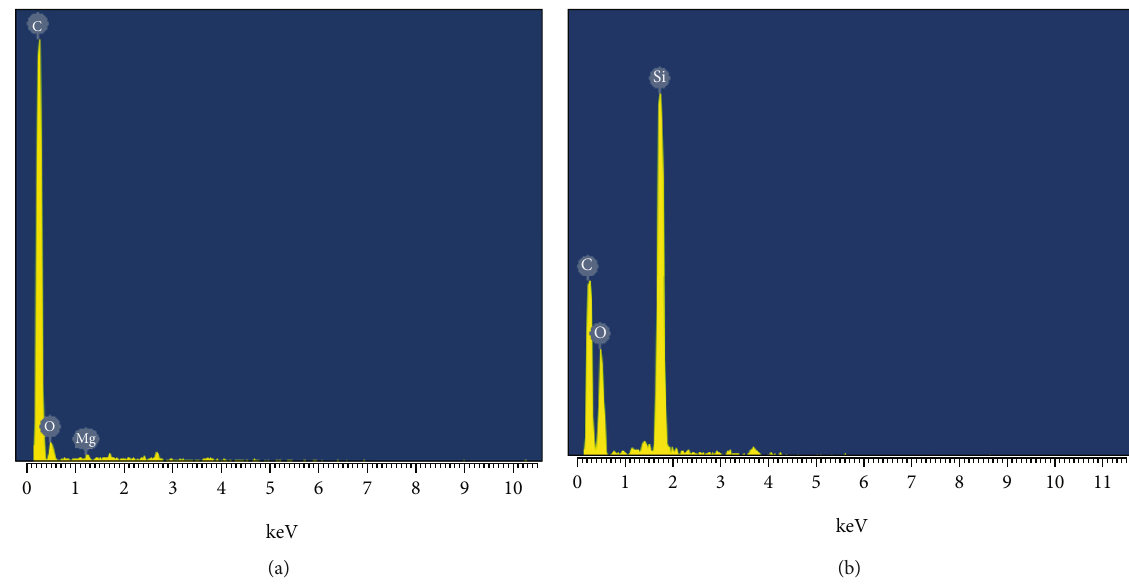
Figure 9: Energy dispersive spectrum corresponding to a SEM image analysis position of BC1 (a) and BC2 (b). Table 2: Average mass percentage of surface elemental composition in